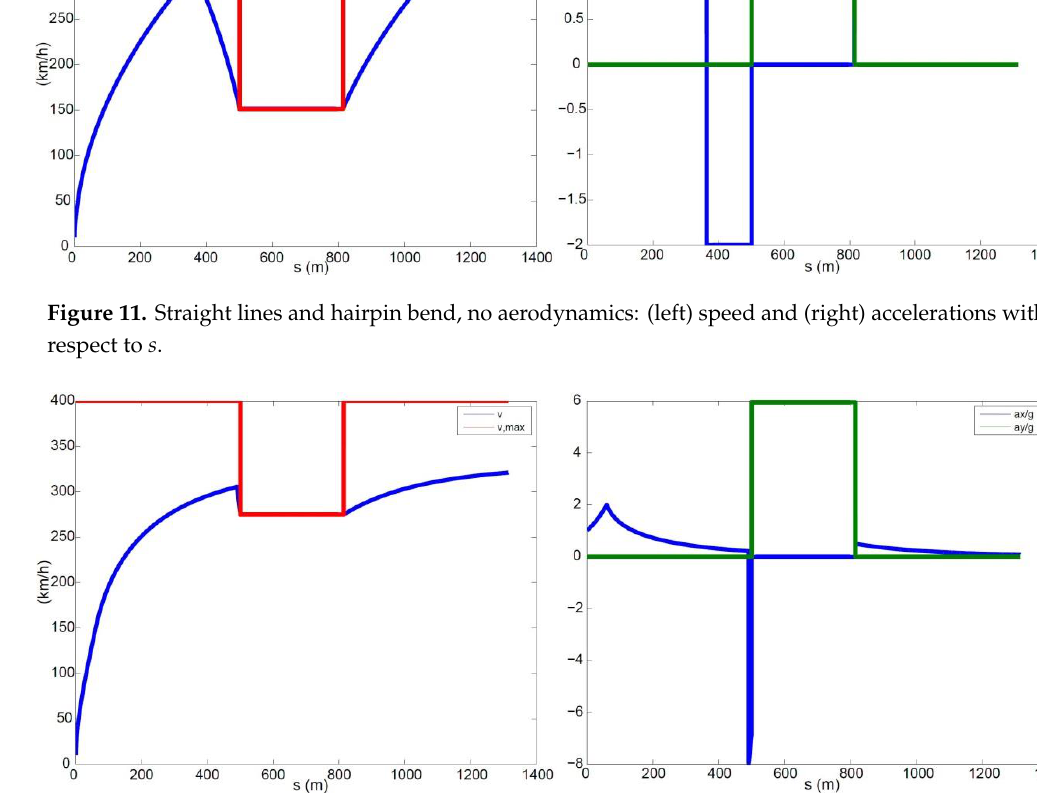
Figure 12. Straight lines and hairpin bend, aerodynamics: (left) speed and (right) accelerations with respect to s